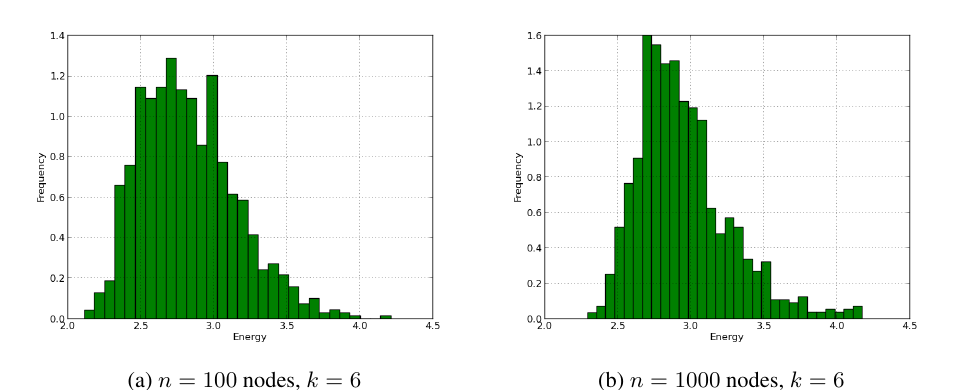
Fig. 2: Different maximal energy dependently on the size of the